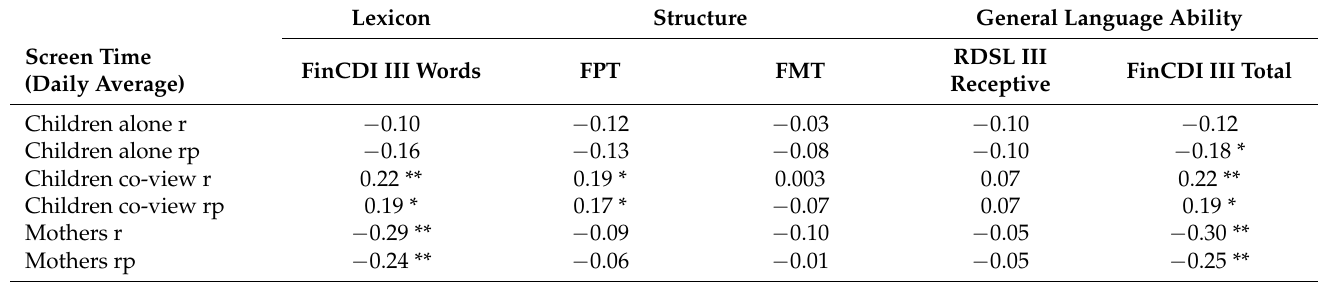
Table 3. Pearson’s correlation co-efficient values (r) between screen time of children and mothers and children’s language ability. Partial correlations (rp; children’s age controlled) are shown separately.